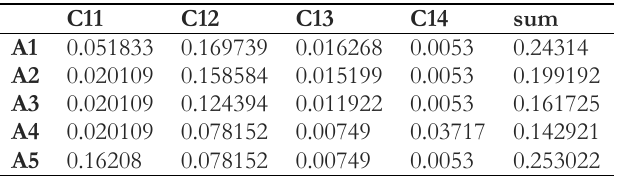
Table 5. The combination matrix of weights: Subcriteria of main criterion C1.